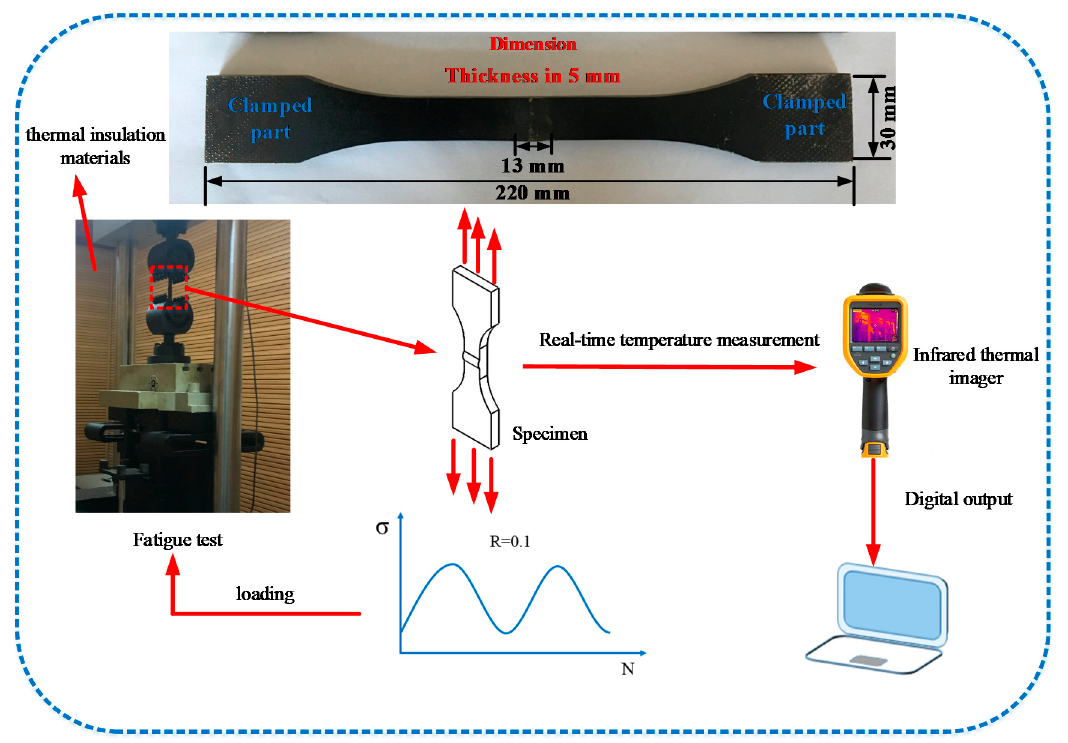
Figure 5. Experimental apparatus.